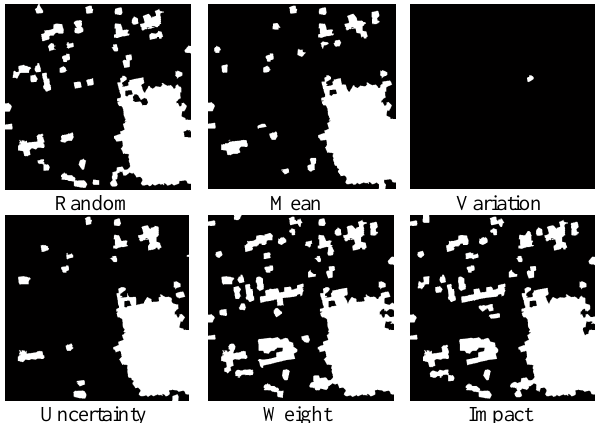
Figure 5. The change detection results for different query strategies with active learning.